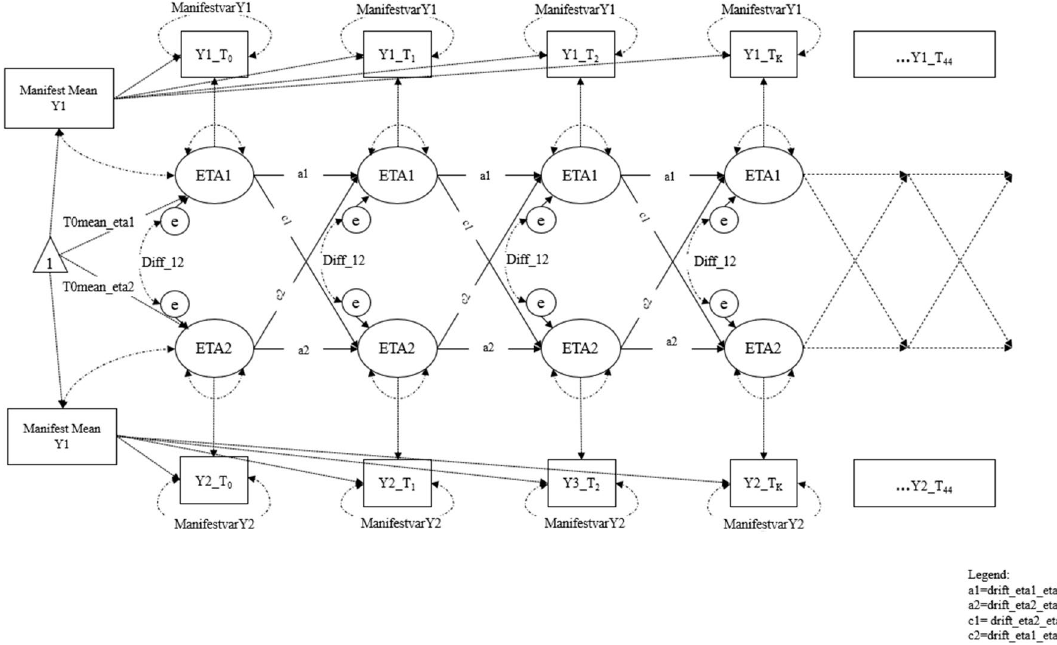
Figure 1. Graphical representation of a hierarchical Bayesian continuous time structural equation model with two manifest indicators (Y1 and Y2) measuring within-effects of two latent processes (ETA1 and ETA2). Legend: Y1 = Well-being; Y2 = Frequency/Duration ofsmartphone use; Manifest Mean = Continuous manifest intercept (Between-person component); Manifestvar = variance and covariance of manifest indicators (i.e., measurement error); eta1 = latent process of well-being; eta2 = latent process of frequency/duration of use; a1 = drift_eta1_eta1 (auto-effect of well-being); a2 = drift_eta2_eta2 (auto-effect of frequency/duration of use) c1 = drift_eta2_eta1 (cross-effect of well-being on frequency/duration of use); c2 = drift_eta1_eta2 (cross-effect of frequency/duration of use on well-being); Diff = covariance of the latent process. In the model, process intercepts are set to 1.00. Regressions and variances in the latent portion are all (after the first time point) conditional on the time interval.